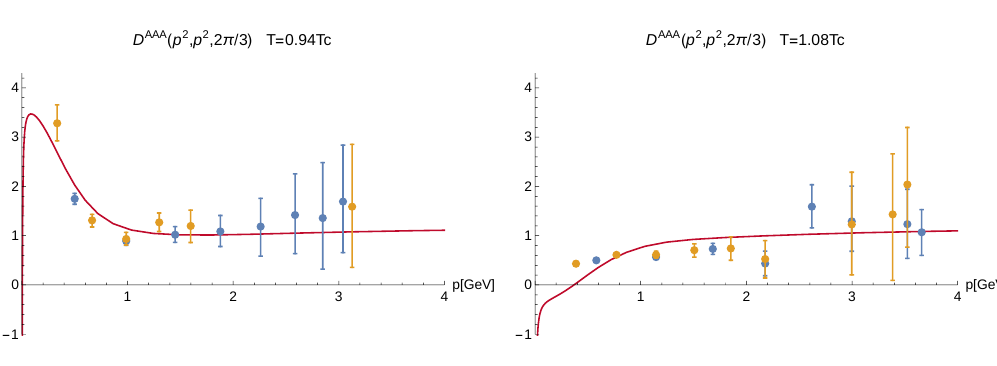
Figure 7. Three-gluon vertex dressing function at the symmetric point in comparison to lattice results